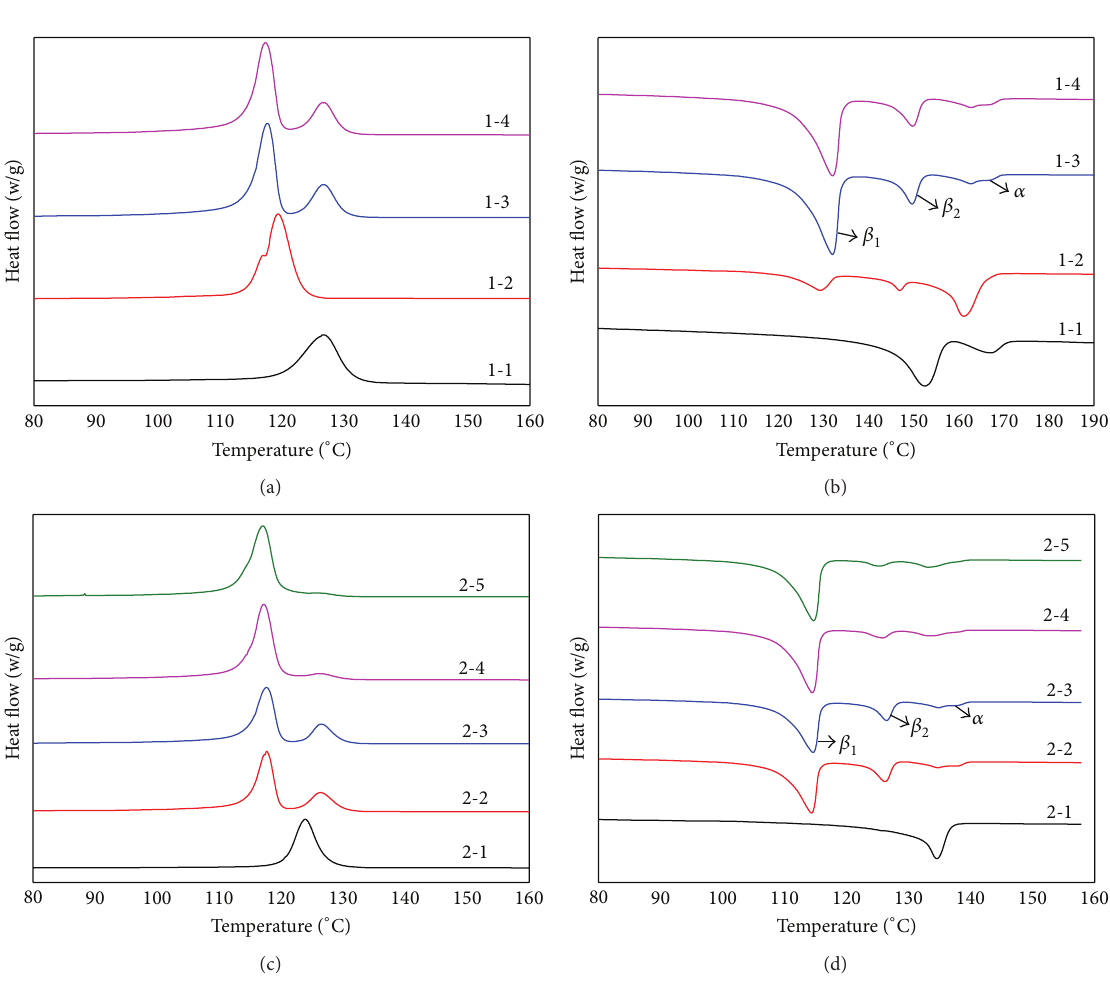
Figure 3: DSC crystallization ((a) and (c)) and melting ((b) and (d)) curves of